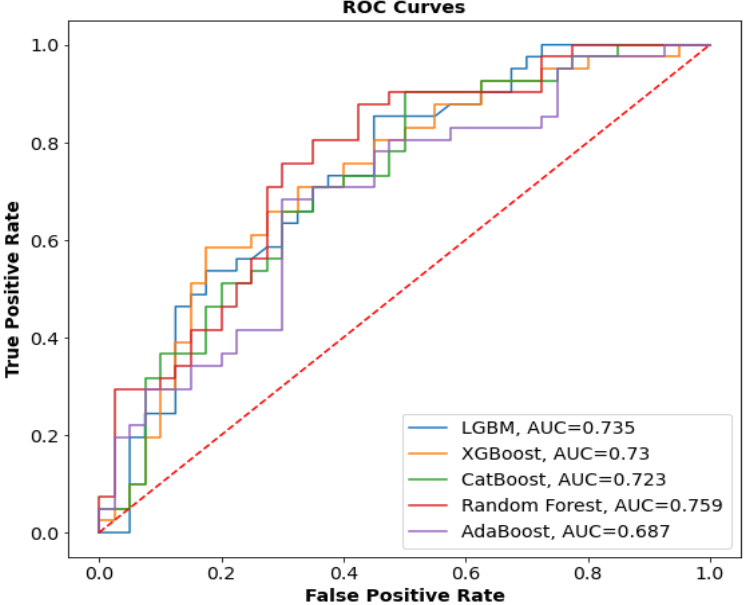
Figure 8. Combined ROC curve for all Bayesian-optimized ELC models.